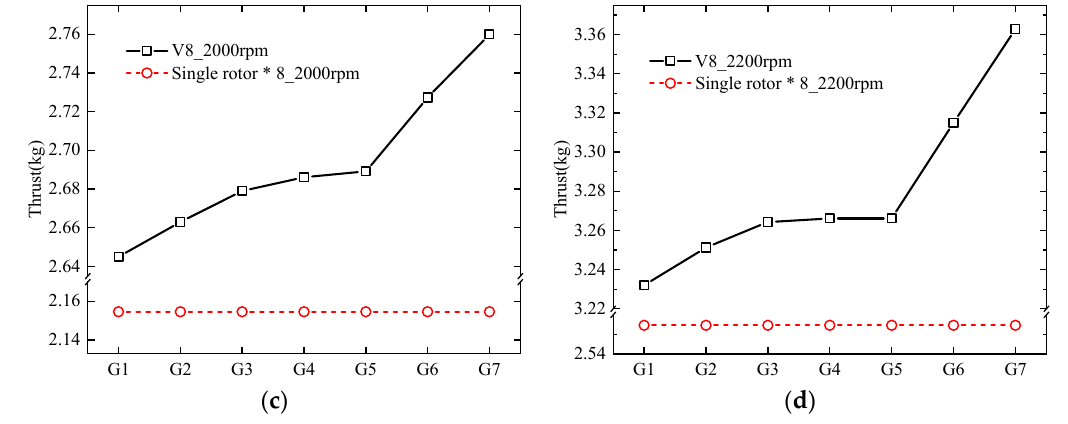
Figure 6. Thrust variation. ( a ) 1600 rpm; ( b ) 1800 rpm; ( c ) 2000 rpm; ( d ) 2200 rpm. The variation of power consumption with increased rotor spacing at 1600 rpm, 1800 rpm, 2000 rpm and 2200 rpm are shown in Figure 7. Power consumption of V8 Octorotor MAV is lower than that of the isolated rotors at 1600 rpm and 1800 rpm, which indicates that this kind of MAV achieved a higher flight duration, especially for a lower rotor speed. The hovering power consumption for G1 and G2 is higher than that of eight single rotors which may be caused the strong interference for a smaller rotor spacing. Additionally, there is clear sudden change at G3 where the lowest power consumption is about 125.743 w. Thereafter, the power increased with the rotor speed. This may be caused by the increasing rotor interference between the adjacent rotors on the same rotor arm with the fixed rotor spacing while the rotor interference is intended to decrease from G5 to G7 with the increasing rotor spacing.